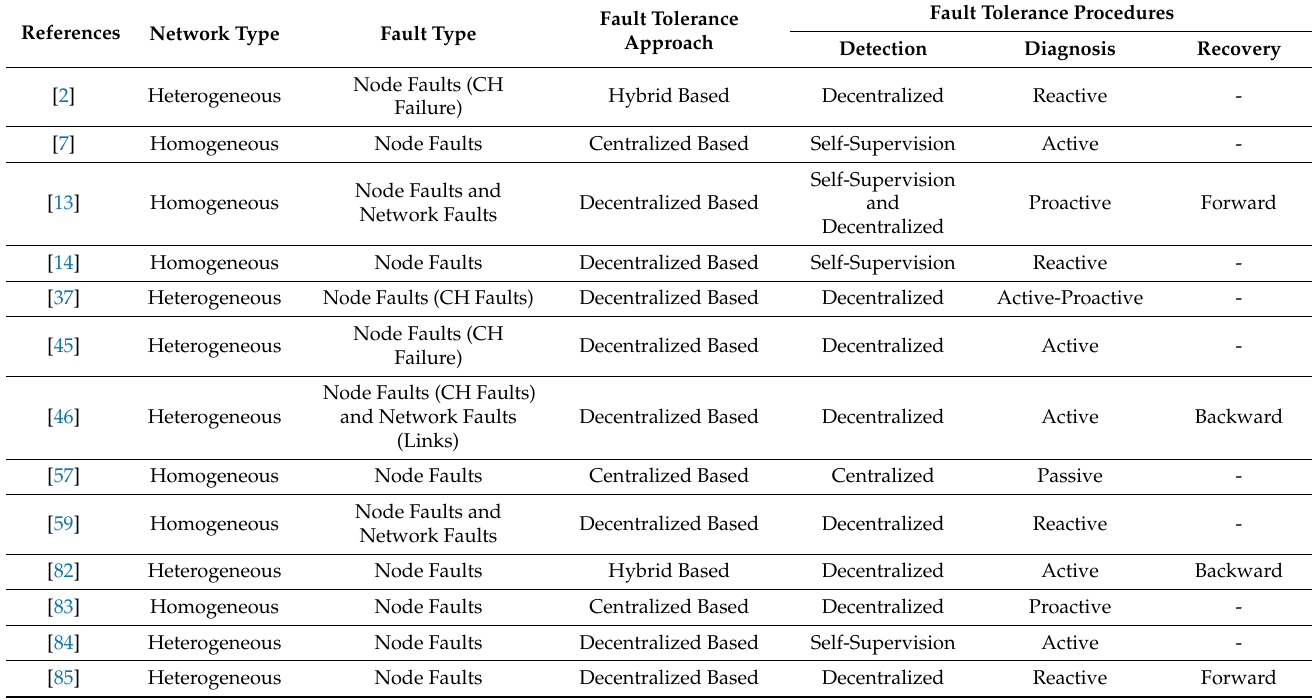
Table 4 classified the aforementioned scientific articles according to error types, fault tolerance approaches, and fault management structure detailed in Sections 3, 4 and 6, according to the main parameters related to presenting and designing an efficient fault management structure for WSNs, represented in Section 5. The constraints include detection accuracy, energy consumption, latency, scalability, and communication cost, among others. The assessment of the existing frameworks is shown in Appendix A. Table 4. Network Type, Fault Type, and Fault Management